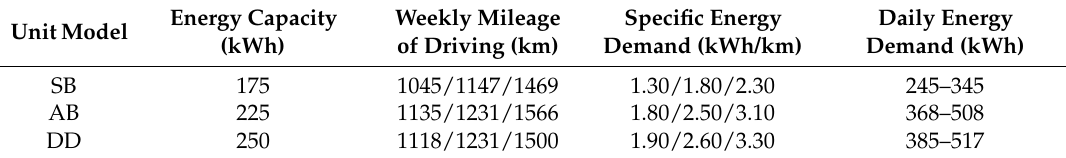
Figure 3. Approximated energy demands of electric buses (eBus) summarized for defined operating scenarios. Table 1. Set of unit models H mstor of electric buses (eBus) specified by the energy capacity, weekly mileage, and specific energy